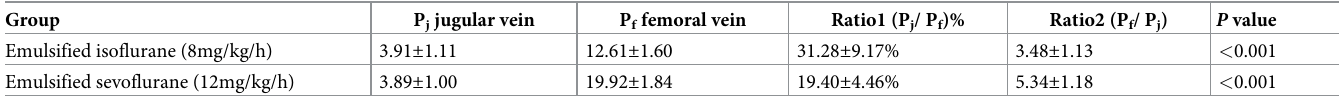
Table 4. The partial pressure of isoflurane and sevoflurane (mmHg) in the jugular (P j ) and femoral vein (P f ) in two groups (mean ± SD). Group